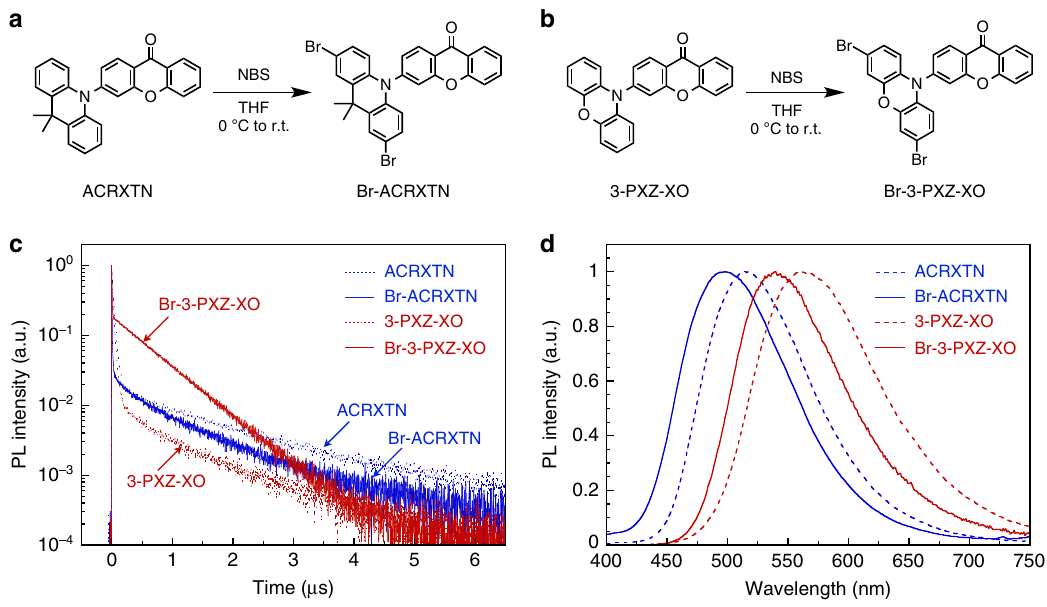
Fig. 3 Synthesis and photoluminescence properties of the brominated molecules. a , b Synthetic routes to Br-ACRXTN ( a ) and Br-3-PXZ-XO ( b ). c , d Transient photoluminescence decays ( c ) and steady-state photoluminescence spectra ( d ) of ACRXTN, Br-ACRXTN, 3-PXZ-XO, and Br-3-PXZ-XO in a solid-state host matrix, 2,8-bis(diphenylphosphoryl)dibenzo[ b , d ]furan (PPF), at a doping concentration of 5 wt%.